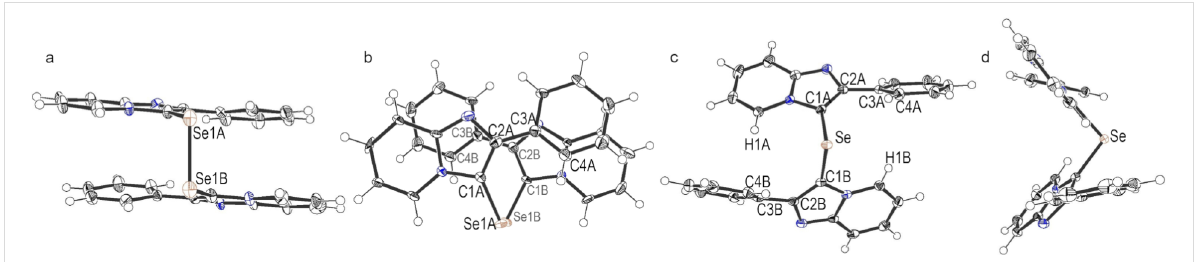
Figure 2: Ortep drawings of 2a (a and b) and 3a (c and d, thermal elipsoids indicate 50% probability).